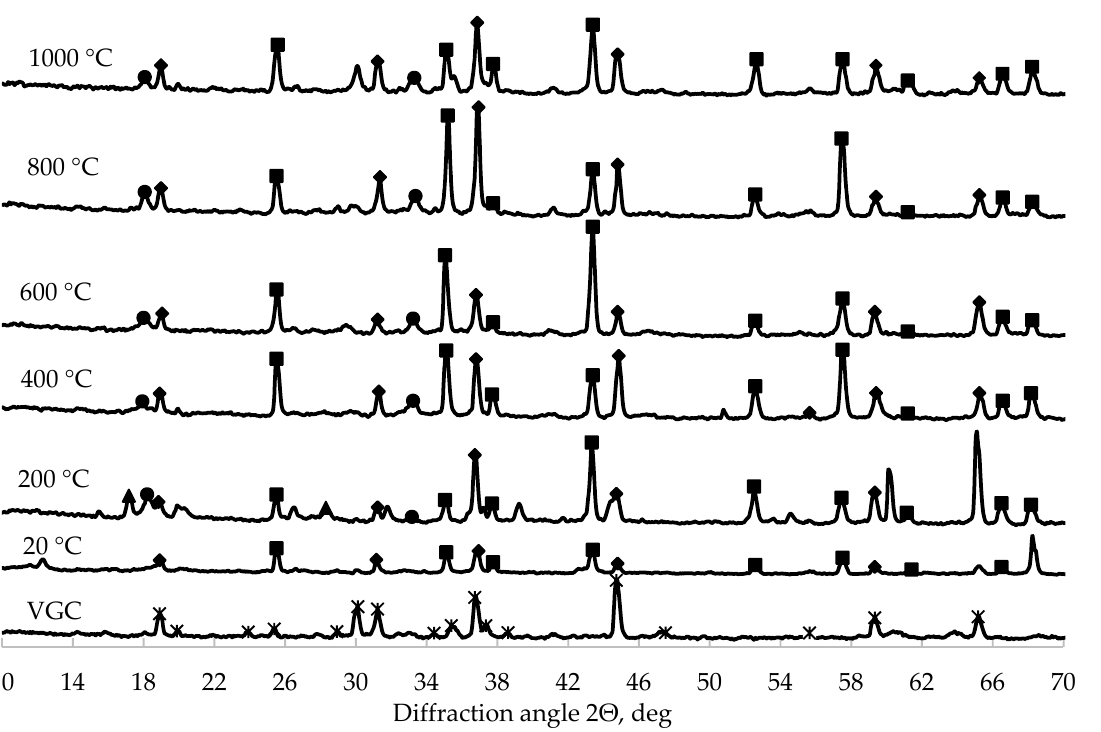
Figure 11. X-ray di ff raction pa tt ern of HACk concrete specimens before and after heat treatment: ■ Figure 11. X-ray diffraction pattern of HACk concrete specimens before and after heat treatment: = Al 2 O 3 ; ◊ = spinel; ● = Ca(OH) 2 ; ▲ = CaAl 2 O 4 ; * = VGC. (cid:4) = Al (cid:7) = spinel; • = Ca(OH) (cid:78) = CaAl 2 O 3 ; 2 ; 2 O 4 ; Ж =